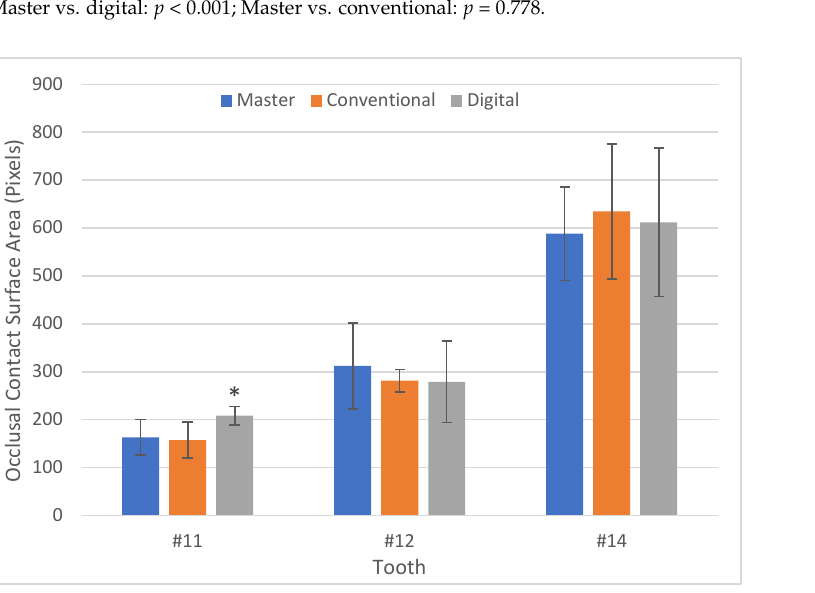
Figure 4. Occlusal contact surface area (pixels) post image processing. * Asterisk indicates statistical significance of p < 0.001.